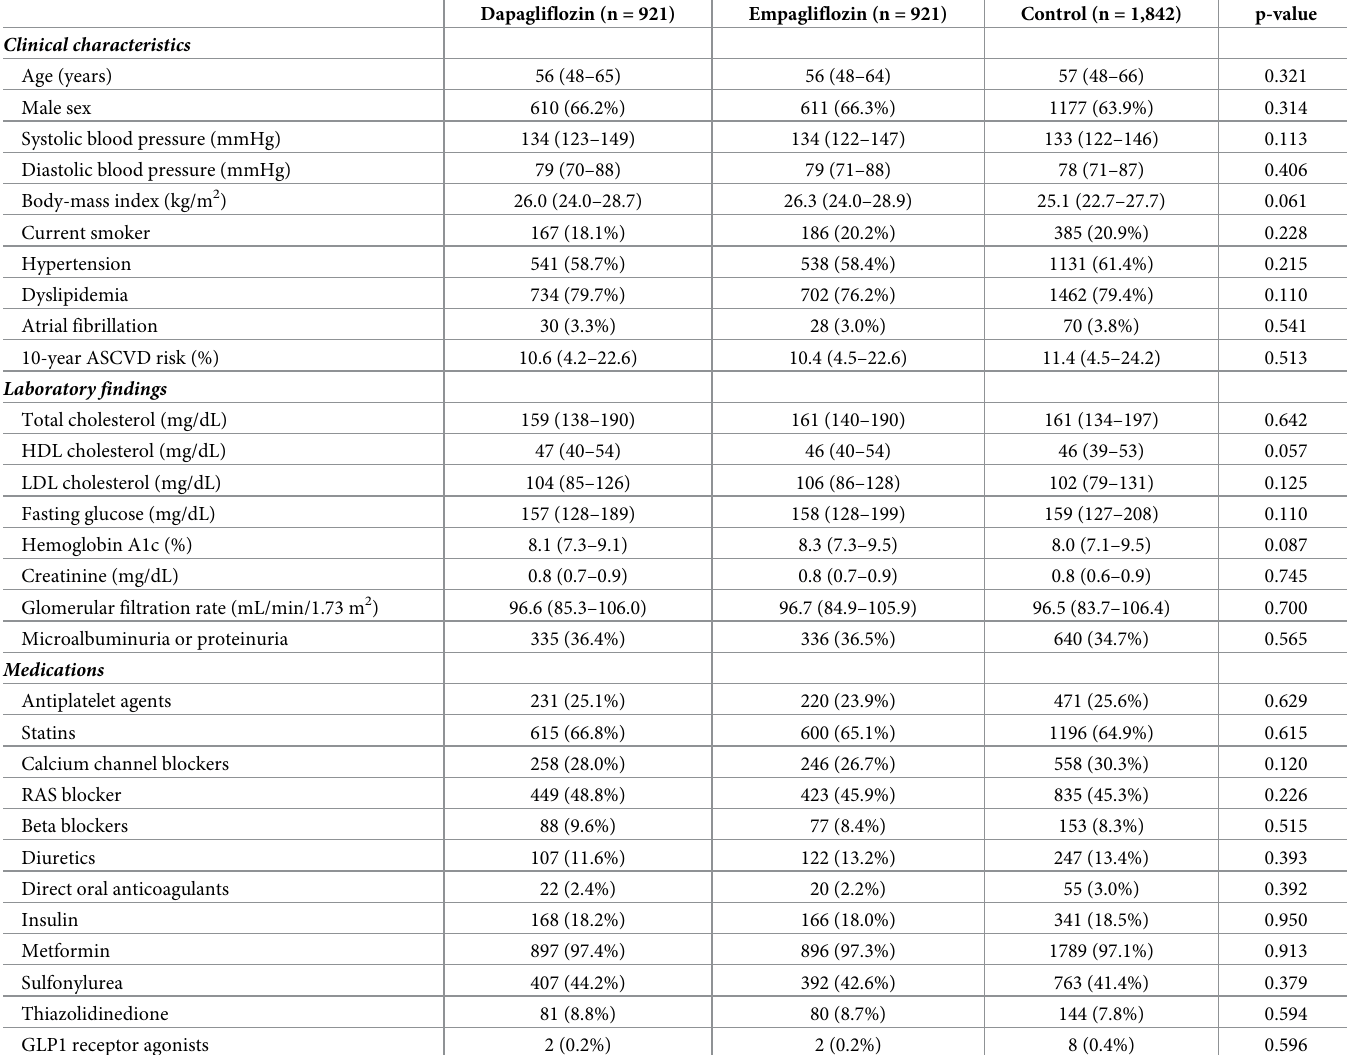
Table 1. Baseline